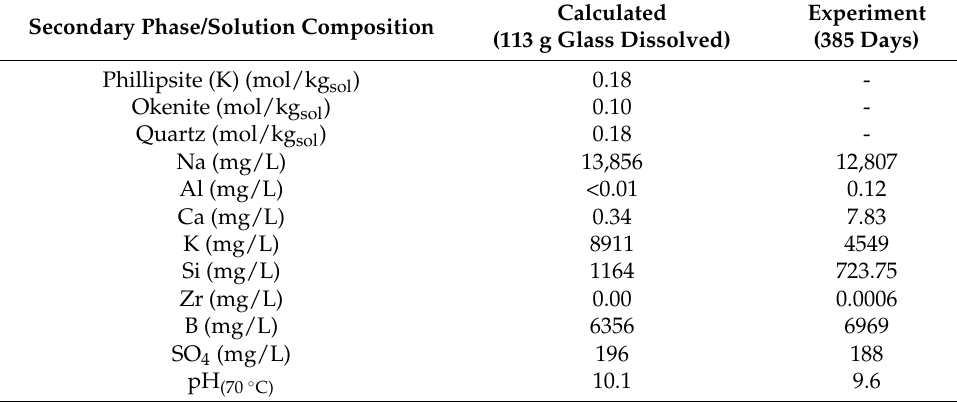
Table 3. Calculated amounts of secondary phases and calculated and measured solution composition after 385 days in YCWCa at 70 ◦